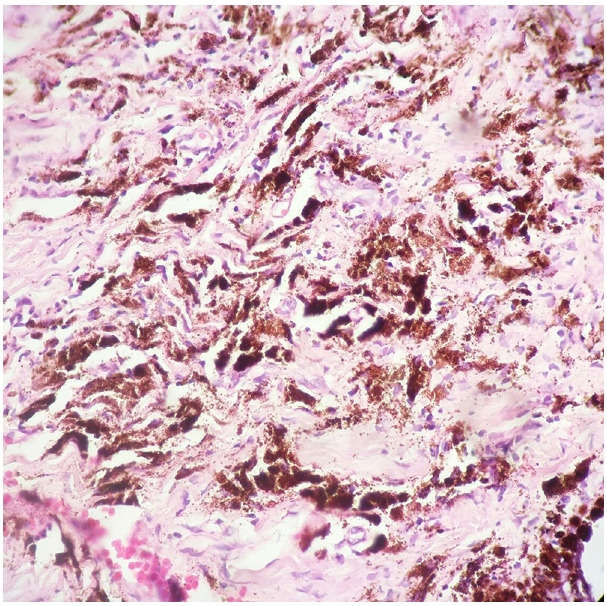
Fig. 2. Histological section of the palatal